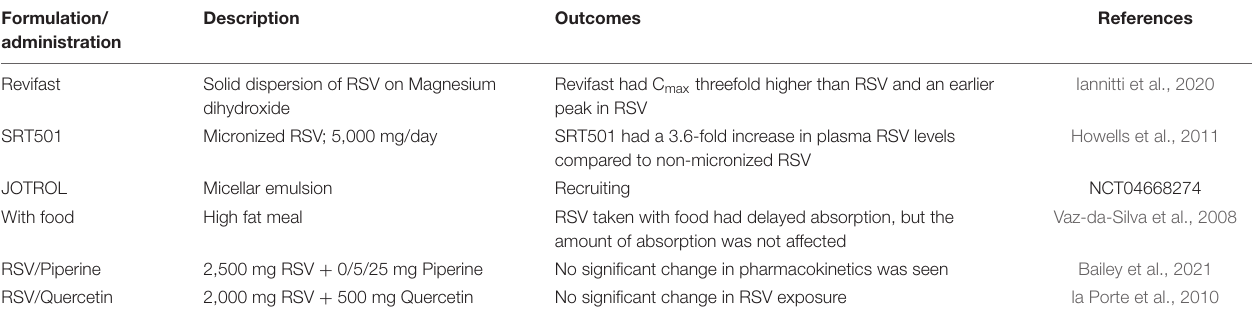
TABLE 1 | Clinical trials examining pharmacokinetics of novel resveratrol formulations and administrations.